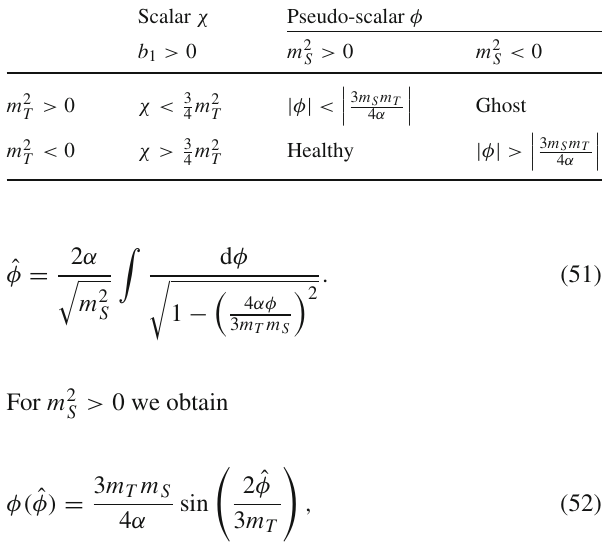
Table 1 This table summarises the conditions to avoid ghosts for the scalar and the pseudo-scalar fields Scalar χ Pseudo-scalar